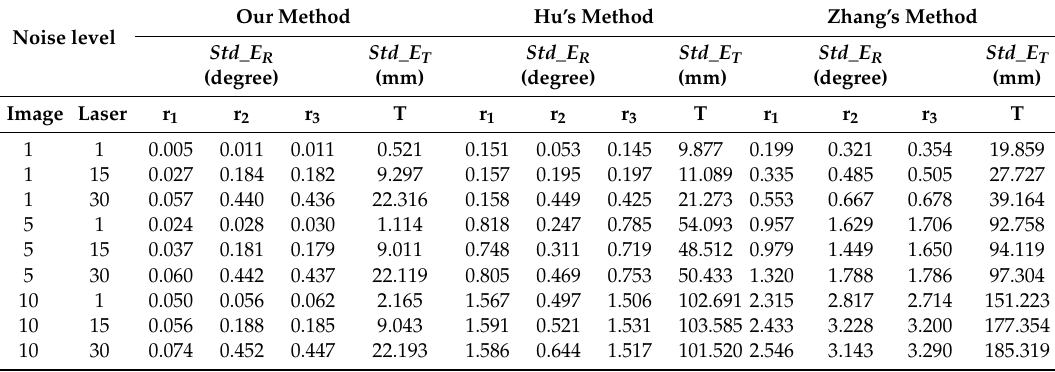
Table 2. Standard deviation of the extrinsic calibration errors under di ff erent noise levels.